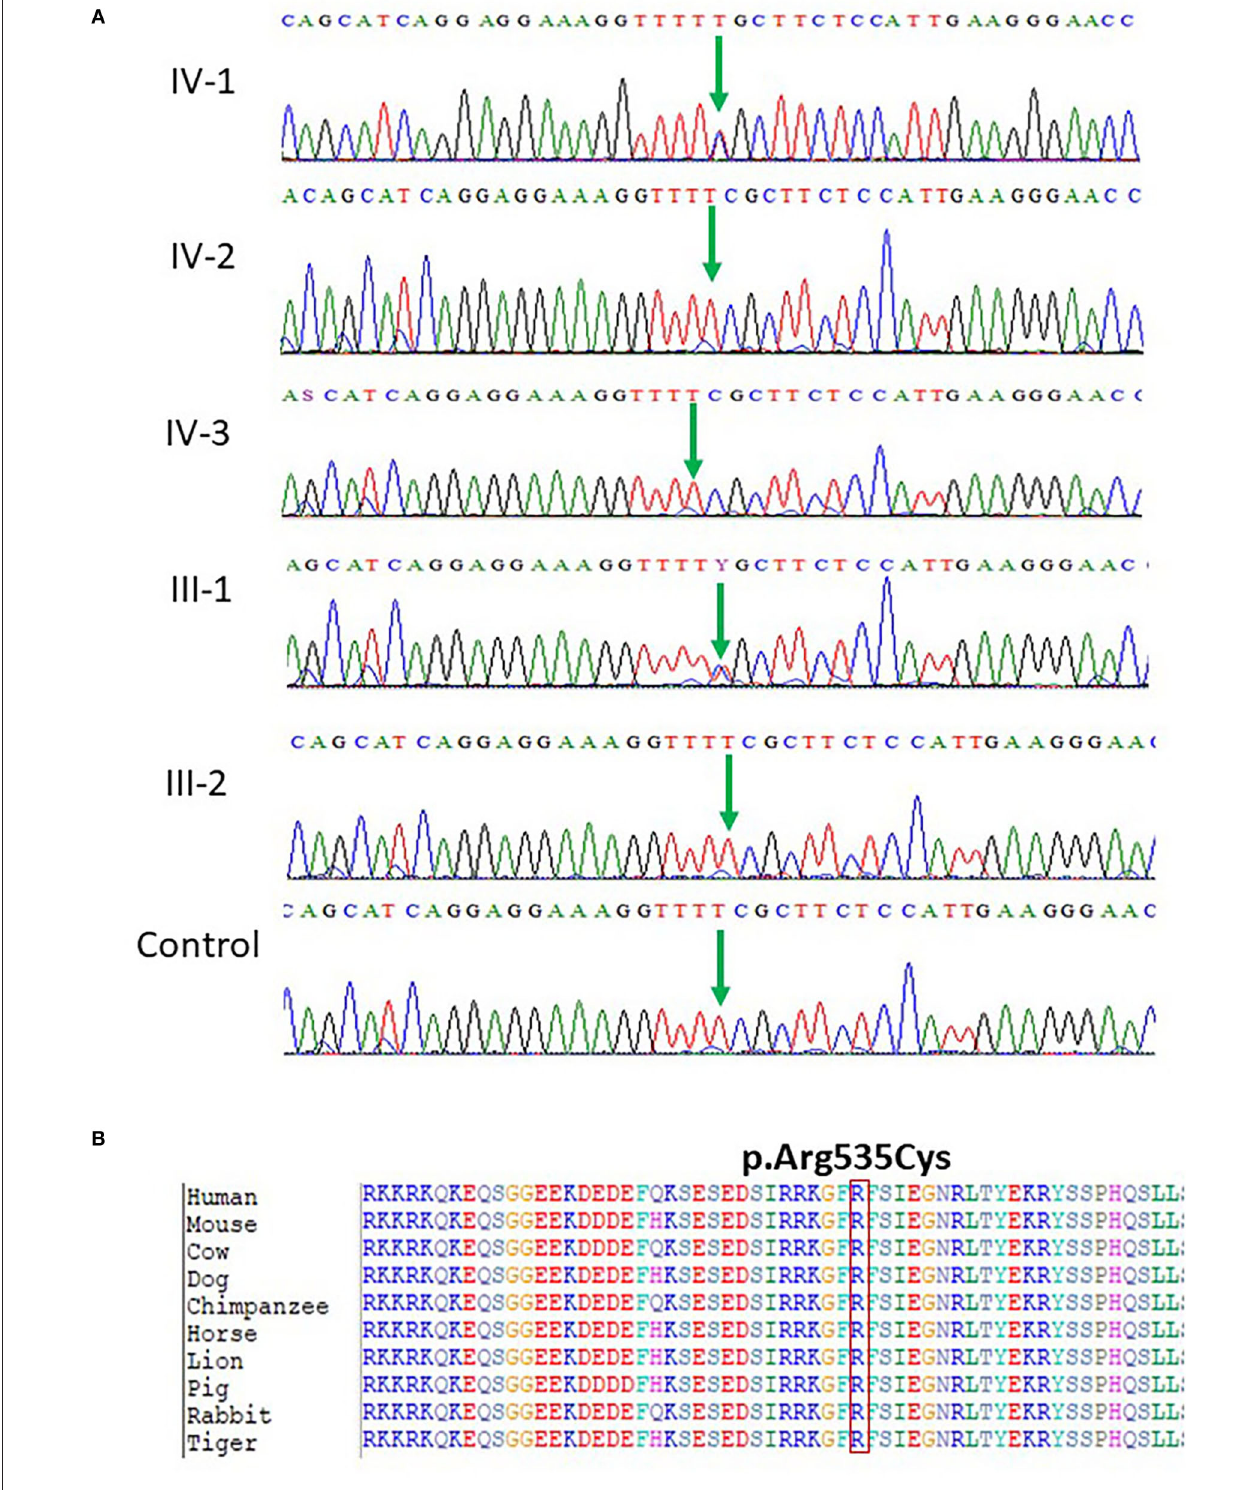
FIGURE 2 | (A) Chromatogram of novel missense variant c.1603C > T, p.Arg535Cys in exon 10 of the SCN1A gene showing that III-1 (mother) and IV-1 (affected girl) are heterozygous having C/T alleles, while all other members are normal having T/T alleles. (B) Protein alignment of different species was done to show the highly conserved amino acid variants p.Arg535Cys SCN1A gene highlighted in all species.